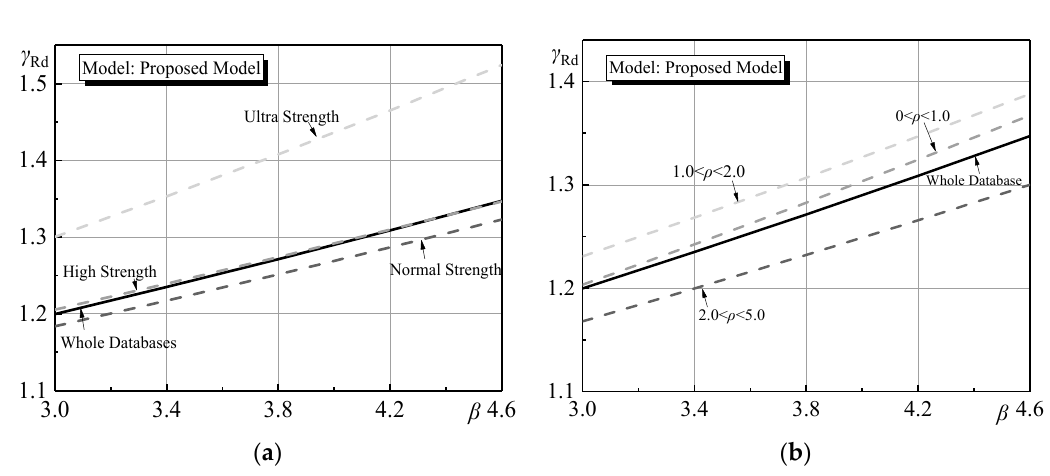
(cid:48) /MPa. ( b ) ρ c